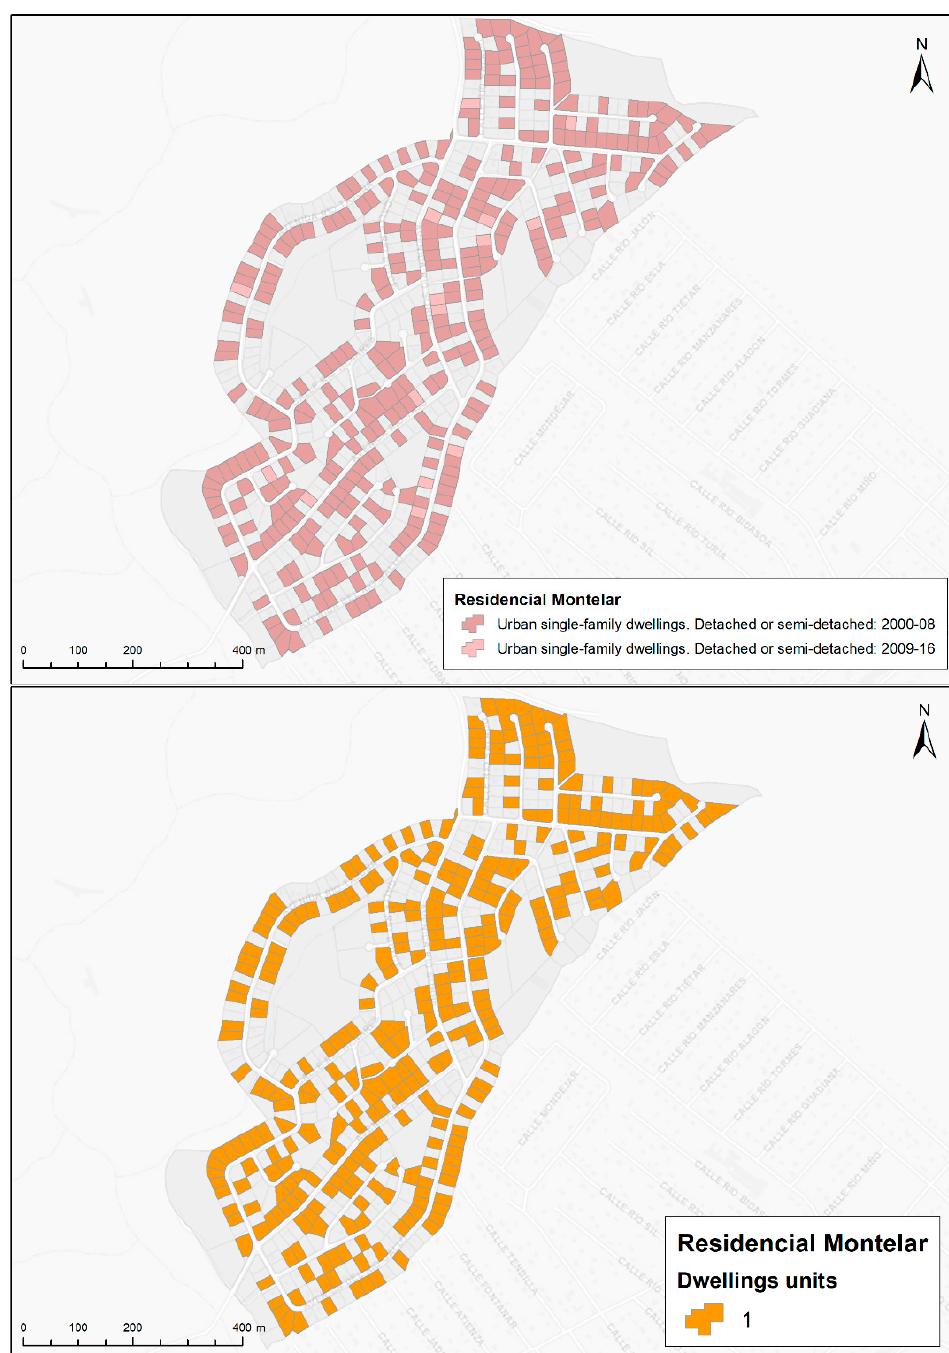
Figure 11. Number of dwellings and construction types. Own elaboration.